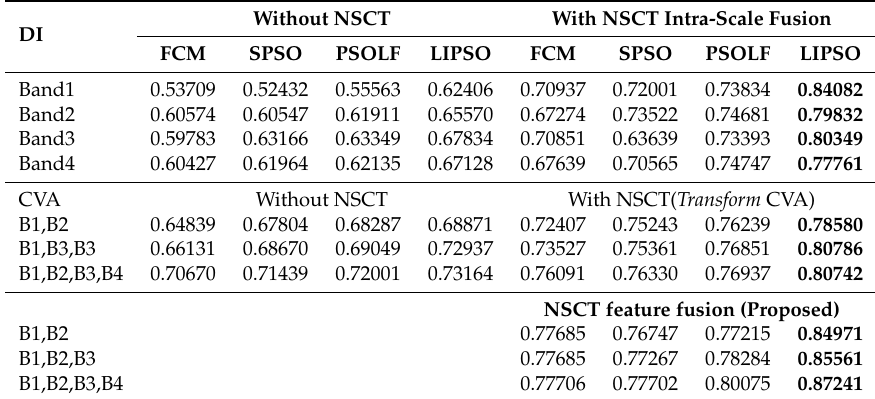
Table 6. Kappa statistic obtained for FCM [3], SPSO [47], PSOLF [43], LIPSO (proposed) of Dubai City